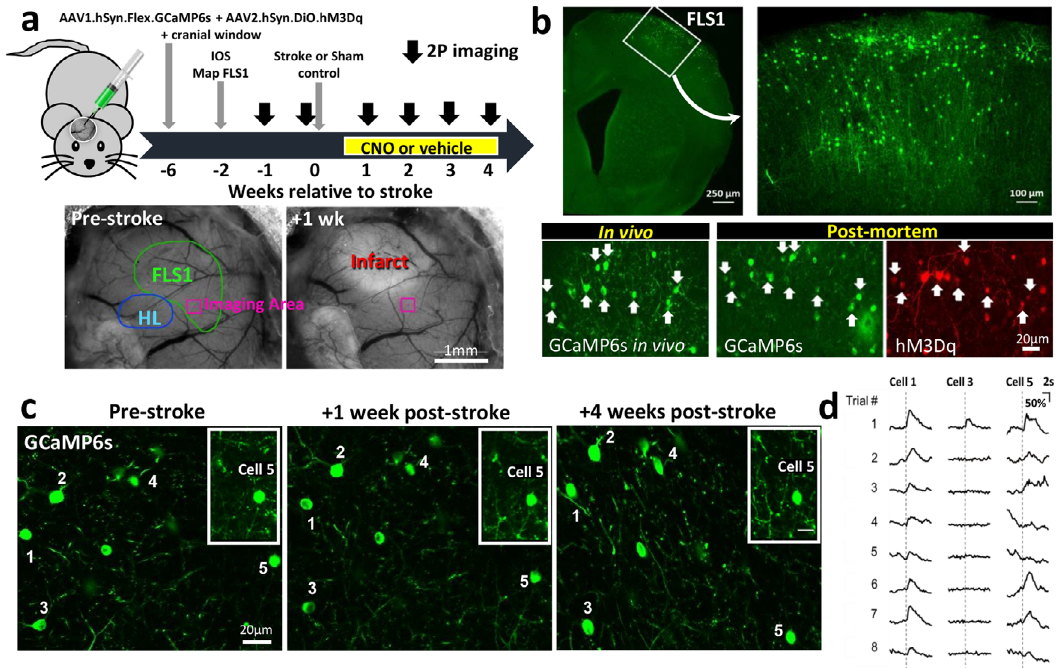
Fig. 3 Long-term imaging of sensory responses in VIP interneurons. a Top: Schematic summarizing the timeline of surgical procedures and 2-photon (2P) imaging of VIP interneuron responses to forelimb stimulation. Bottom: surface images show the location of 2P imaging in FLS1 cortex relative to the infarct. The colored contours shown for FLS1 and HLS1 were derived from IOS maps thresholded at 75% peak response amplitude. b Top: confocal images show GCaMP6s expression in VIP neurons in forelimb primary somatosensory cortex (FLS1, images representative of all experimental mice). Bottom row: GCaMP6s-expressing VIP neurons imaged in vivo were identi fi ed in post-mortem sections and con fi rmed to express hM3Dq (see white arrows). c Calcium imaging of the same VIP interneurons before stroke and afterwards in peri-infarct cortex (images representative of all experimental mice with stroke). d Traces show trial by trial variability in forelimb-evoked calcium responses (% Δ F/Fo) in three representative neurons (see numbers in c